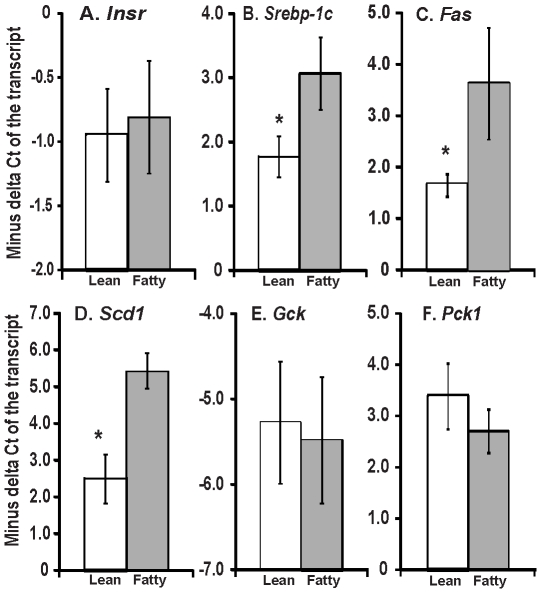
The mRNA levels of Insr (A), Srebp-1c (B), Fas (C), Scd1 (D), Gck (E), and Pck1 (F) in freshly isolated hepatocytes from ad libitum Zucker lean and fatty rats.The primary hepatocytes were isolated from Zucker lean and fatty rats in ad lib. The total RNA was extracted and subjected to real-time PCR analysis. Results were presented as means ± SD of −ΔCt (against 36B4) from five different hepatocyte isolations from lean or fatty rats (* all P<0.05, for comparing the −ΔCt values of the indicated transcripts in hepatocytes from lean rats with those from fatty rats using independent-samples t test).